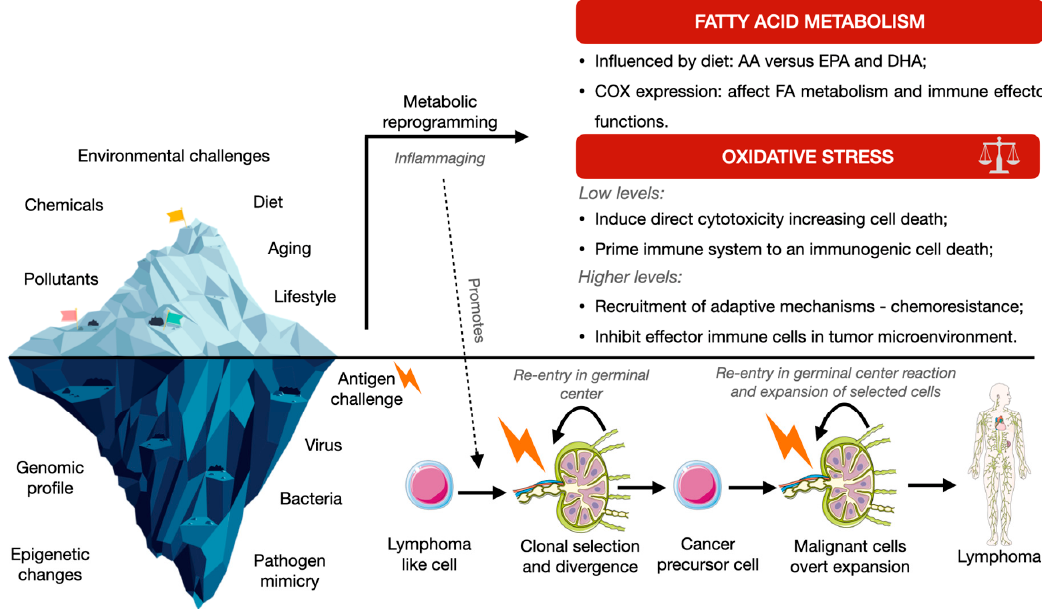
Figure 3. Reactive oxygen species biogenesis and fatty acid metabolism crosstalk in the lymphomagenesis phenomenon. Lymphomagenesis is usually associated with increased levels of ROS, herein exerting inhibitory effects in microenvironment immune cells. Depletion of cancer cells’ antioxidant capacity may become a complementary therapeutical approach. AA—arachidonic acid;